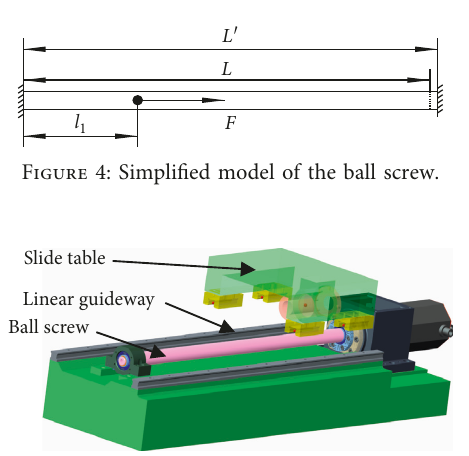
Figure 5: Three-dimensional model of the linear guideway and ball screw system.